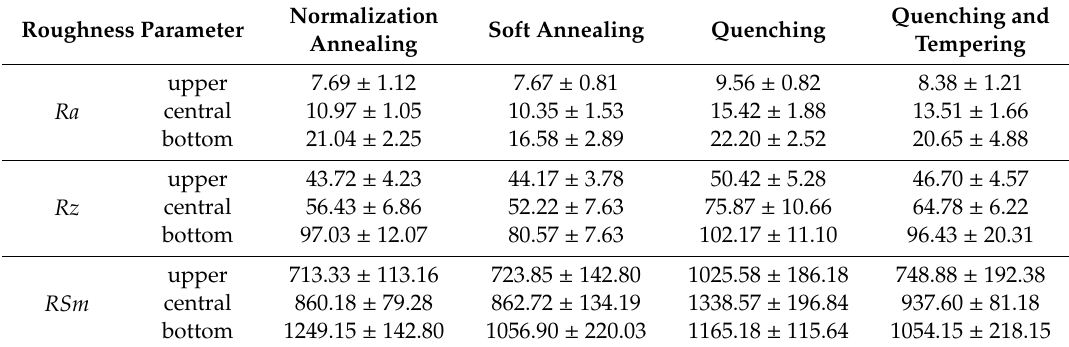
Table 5. Surface roughness characteristics after abrasive waterjet cutting.